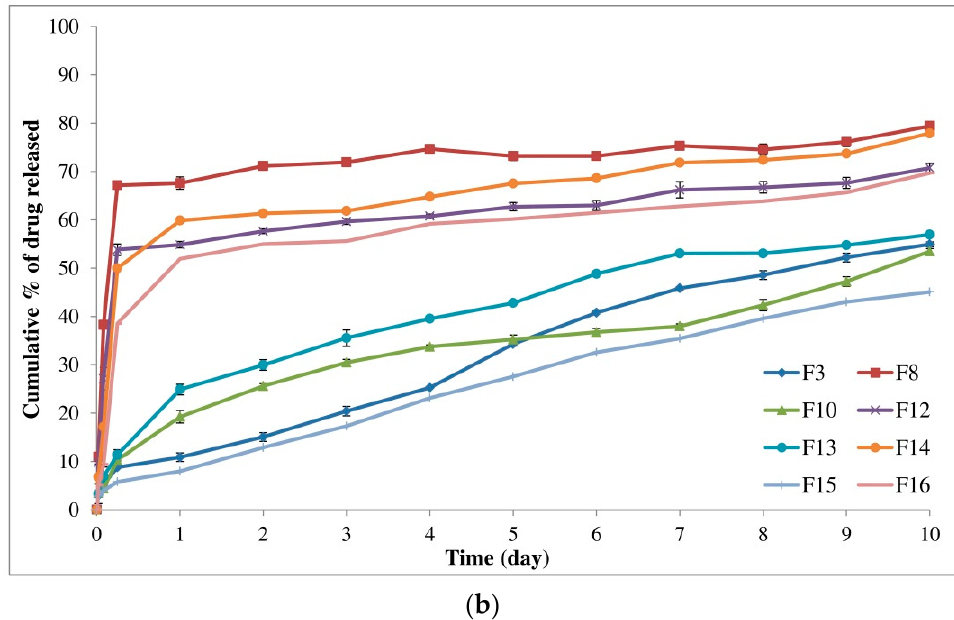
Figure 3. In vitro release of alogliptin-loaded ISGI formulations showing ( a ) individual effects of A and C on measured responses (Y 1 and Y 2 ) ( b ) individual effect of B on measured responses (Y 1 and Y 2 ). On the other hand, the burst release of the drug was reduced from 34.48% to